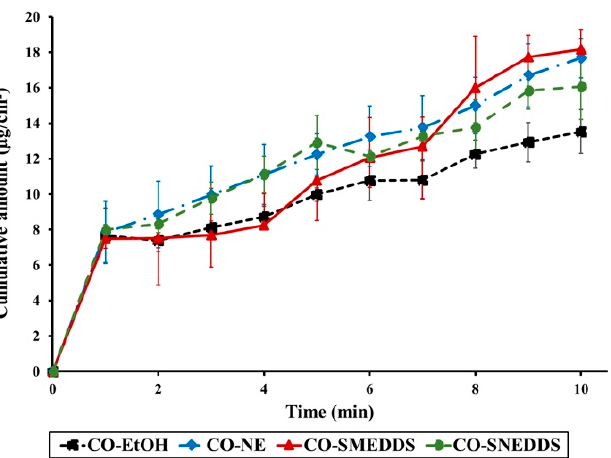
Figure 4. Cumulative permeation of eugenol through zebrafish skin versus time of the different CO formulations. Data are presented as means ± SD ( n = 3).